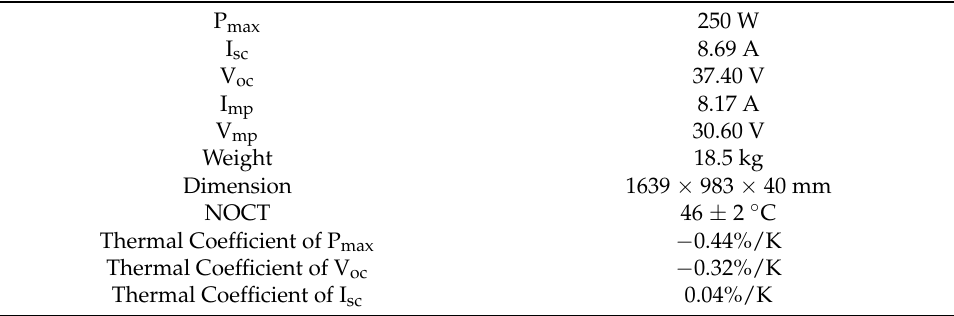
Table 4. SRCSolar XT-250P6B’s electrical properties and thermal coefficients.